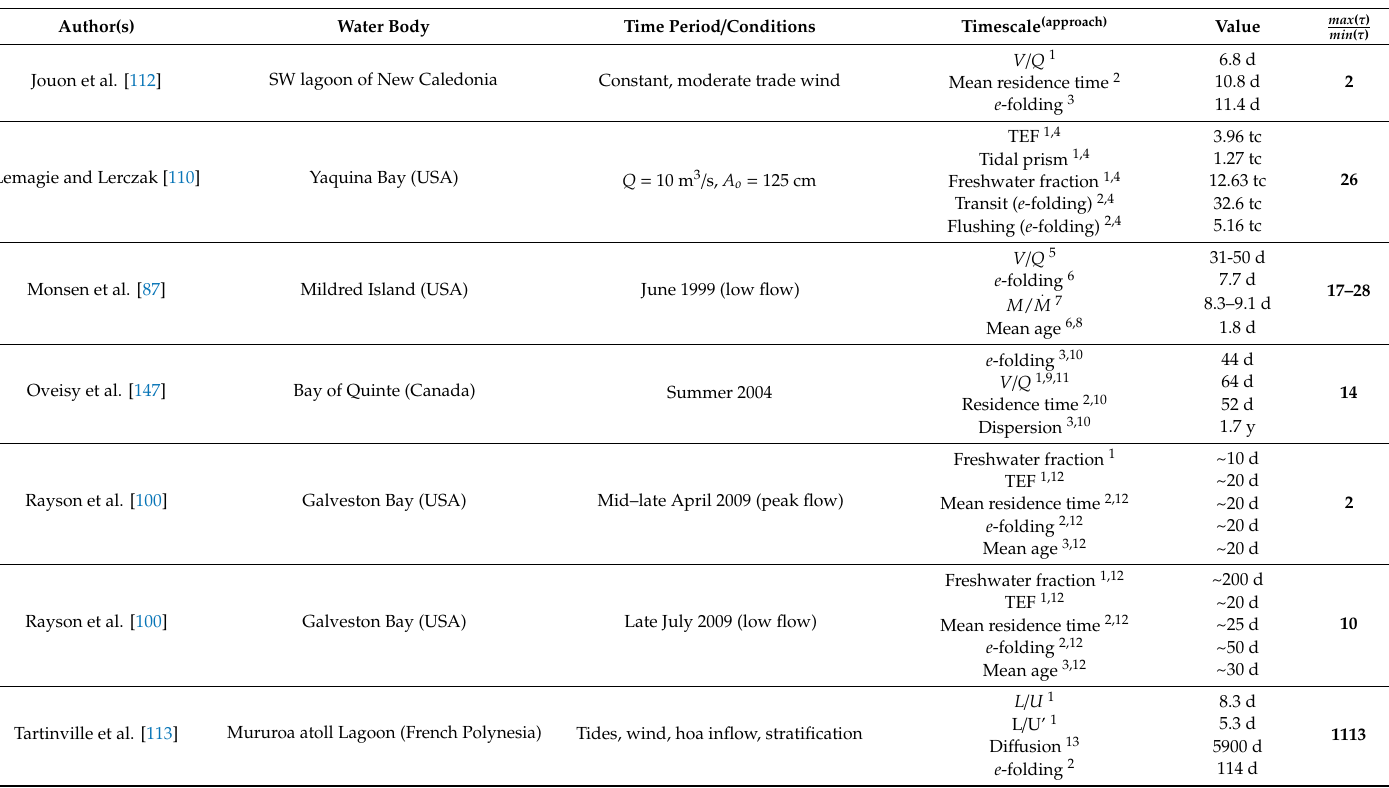
Table 2. Compilation of transport timescales estimated in previous studies. Data is based on sources in “Author(s)” column. max ( τ ) / min ( τ ) is the ratio of the maximum timescale value to the minimum value for a water body and set of conditions. Q is volumetric flow rate. V is water body volume. M is total tracer mass. loading rate. L is length. U is mean velocity. U (cid:48) is average deviation from depth-mean velocity. A o is tidal amplitude. TEF is “total exchange flow” [122], an approach for estimating a salinity turnover time. “tc” is tidal cycles. Footnotes provide methodological information. Other specifics such as temporal or spatial averaging of parameters or timescales vary between authors; please see those publications for